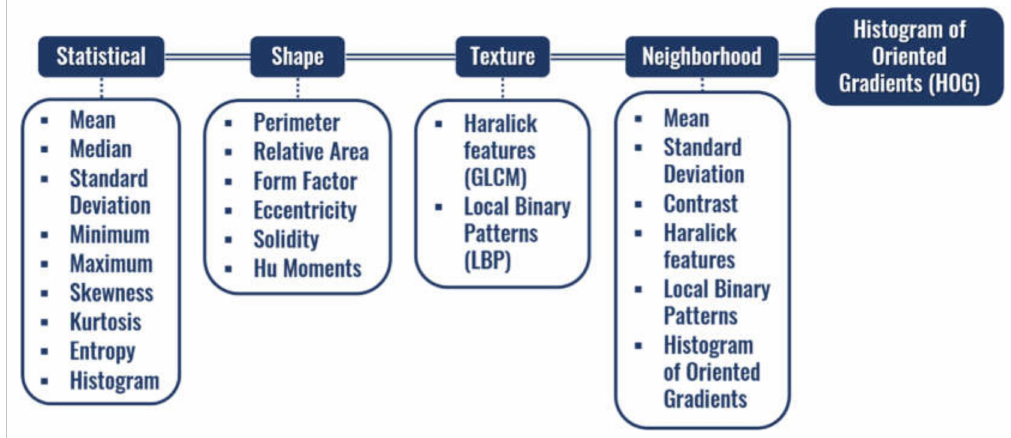
Figure 6. Set of features representing each segment of the Spatial Groups Data Clustering